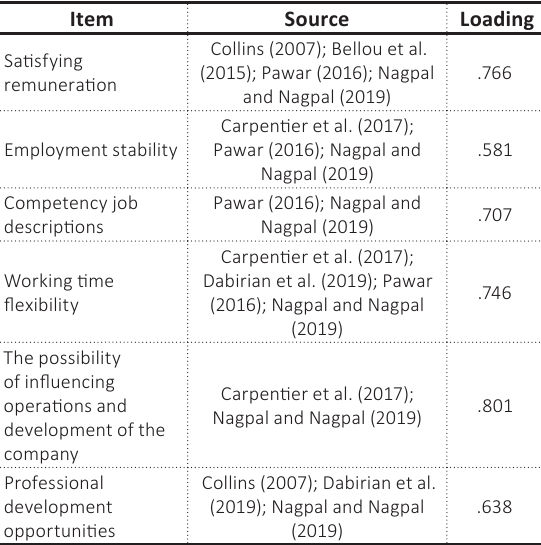
Table 3. Characteristics determining